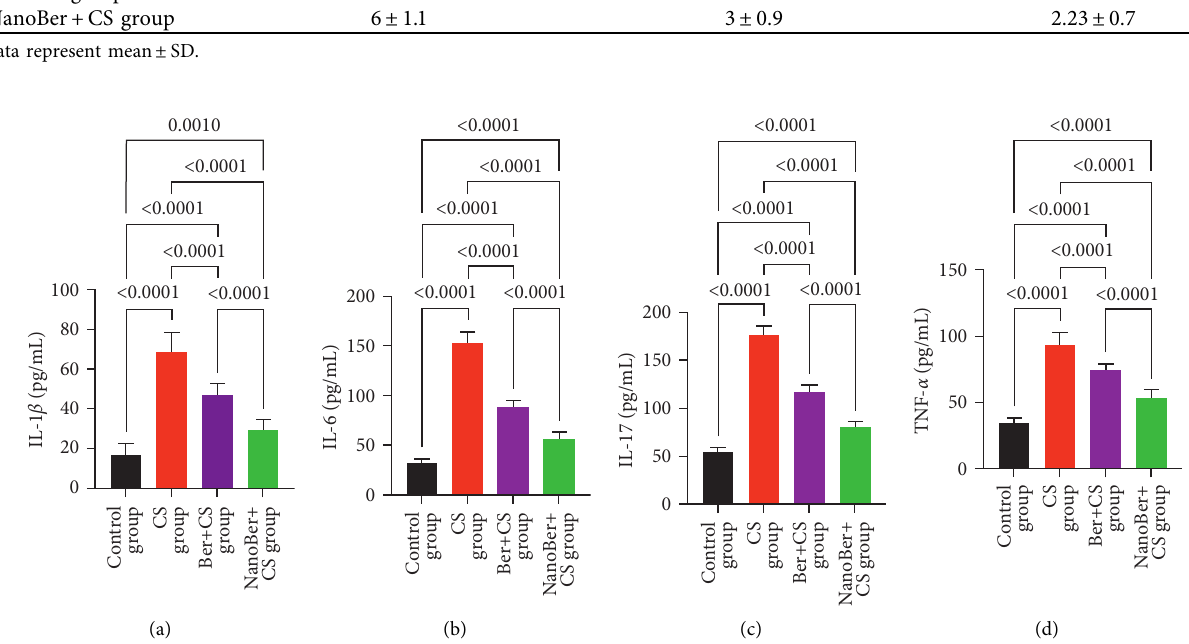
Figure 5: Effect of Ber-loaded SLN-chitosan nanoparticles and the pure suspension of berberine on inflammatory cytokines in BALF in CS- induced COPD rats. Data are expressed as mean ± SD ( n � 10). Statistical analysis was carried out by one-way analysis of variance (ANOVA) followed by Tukey’s multiple comparison test. p < 0 . 05 is considered as statistically